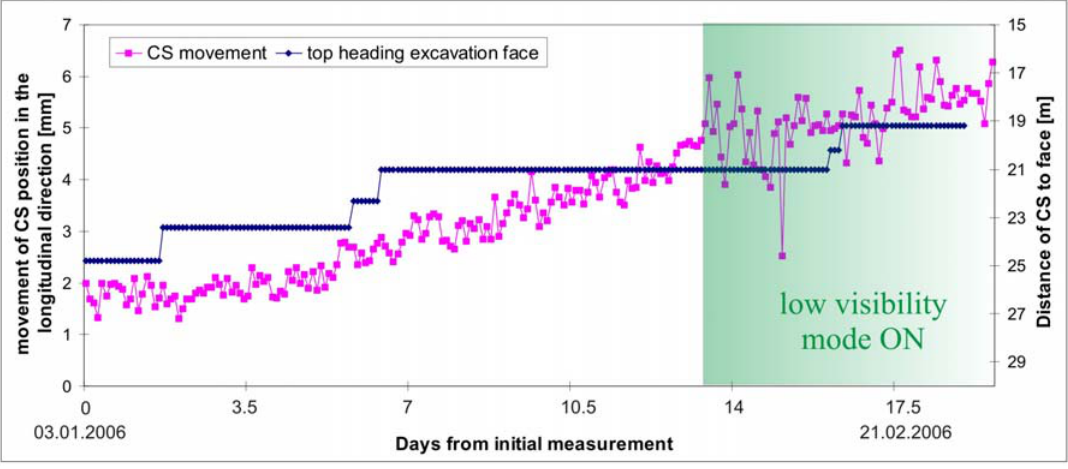
Figure 10. Movement of the position of the control station CS6 in longitudinal direction with plotted distance from control station to the top heading excavation face.